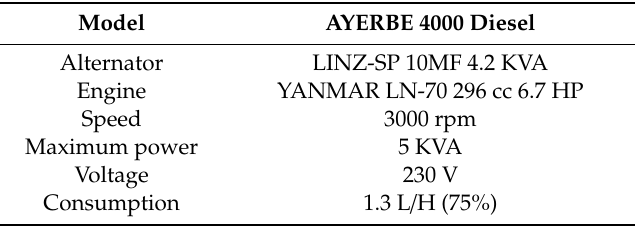
Table 3. Specifications of the Diesel Engine-Electrogenerator